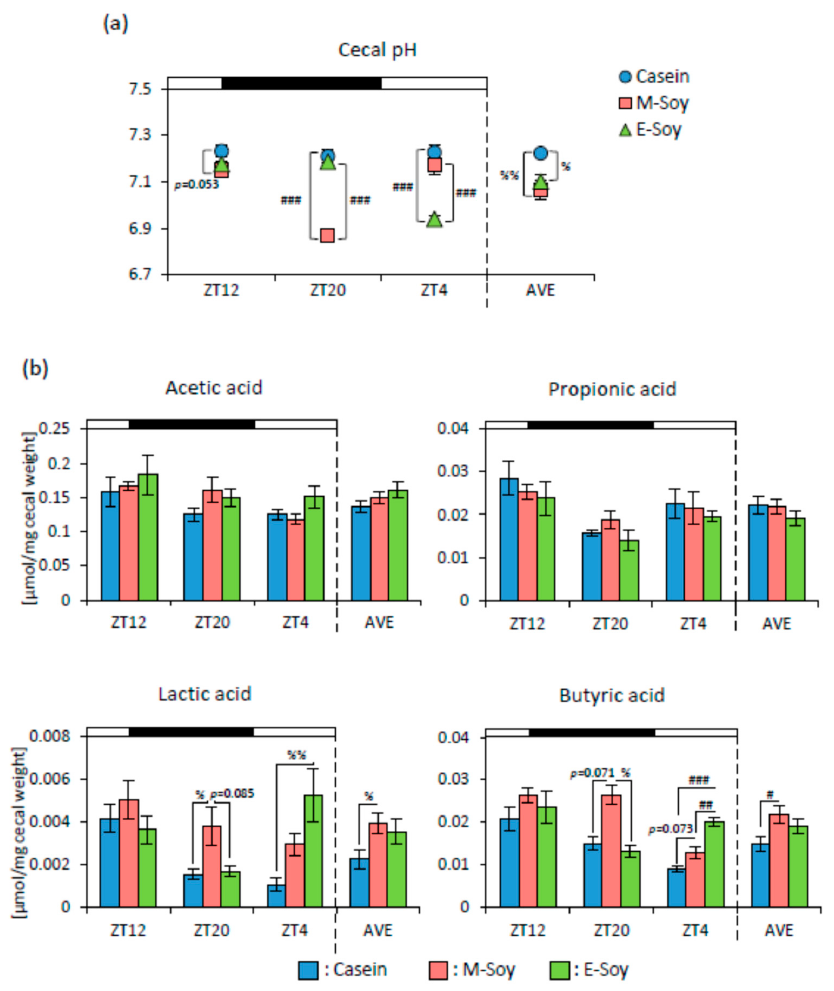
Figure 7. The effect of soy protein intake timing on cecal pH and SCFA levels. ( a ) Cecal pH levels (ZT12, ZT20, ZT4, and an average of three points) of mice that were kept in each feeding condition for two weeks. ( b ) Cecal SCFA levels (ZT12, ZT20, ZT4 and average of three points) of mice that were kept in each feeding condition for two weeks. Data are represented as mean ± SEM ( n = 5). # p < 0.05, ## p < 0.01, ### p < 0.001 evaluated using one-way ANOVA with Tukey’s post-hoc test. % p < 0.05, %% p < 0.01 the Kruskal-Wallis test with Dunn’s post-hoc test.